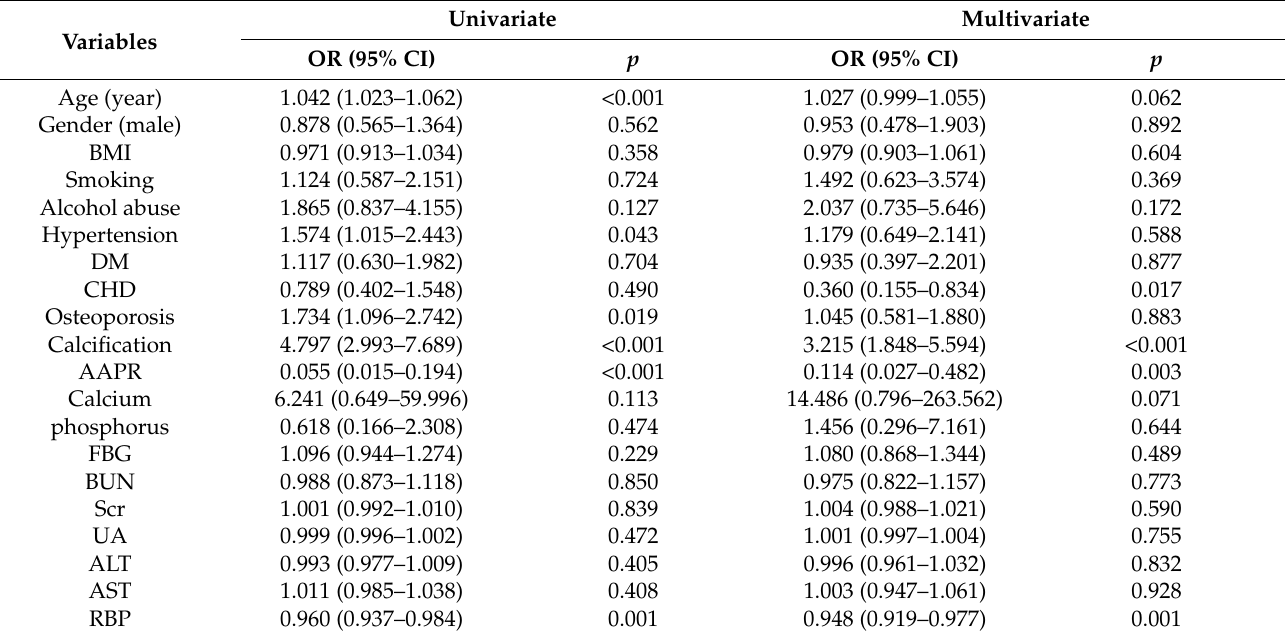
Table 5. Univariate and multivariate analysis model 1 of risk factors for severe